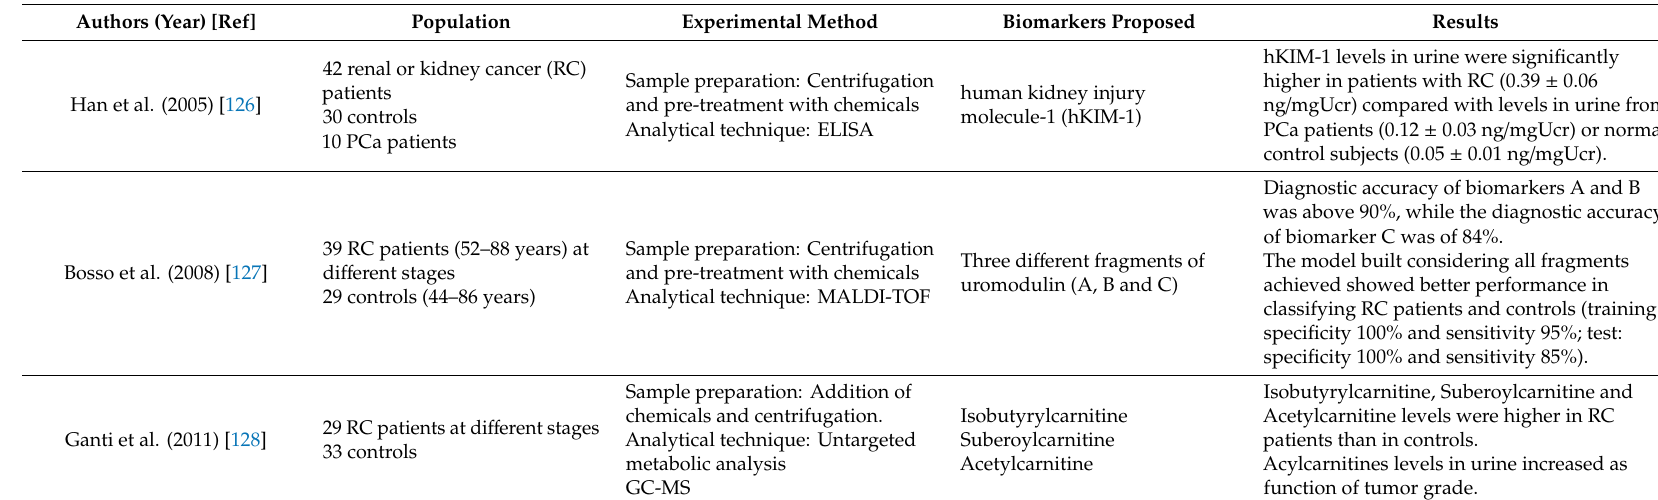
Table 9. Literary studies investigating urinary renal cancer